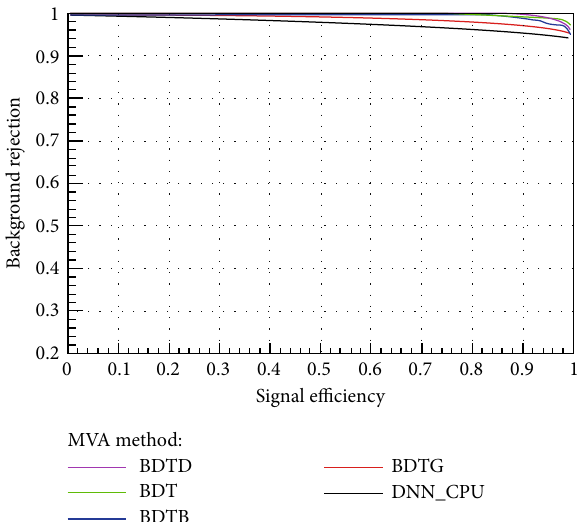
Figure 20: In the analysis, nonlinear approaches were predominantly employed. This is due to the fact that the structure of the signal and background distributions is more accurately re fl ected in this manner. In this regard, linear approaches such as Fisher ’ s and its derivatives are unsuitable for analysis. Again, similar procedures were not adopted since they did not produce successful results. However, other nonlinear approaches were incorporated in this context so that the analysis could be compared to other ways and its evolution could be observed. The results indicate that the inputs are uniformly distributed, no overtraining was seen, and the analysis produced a high level of diversi fi cation